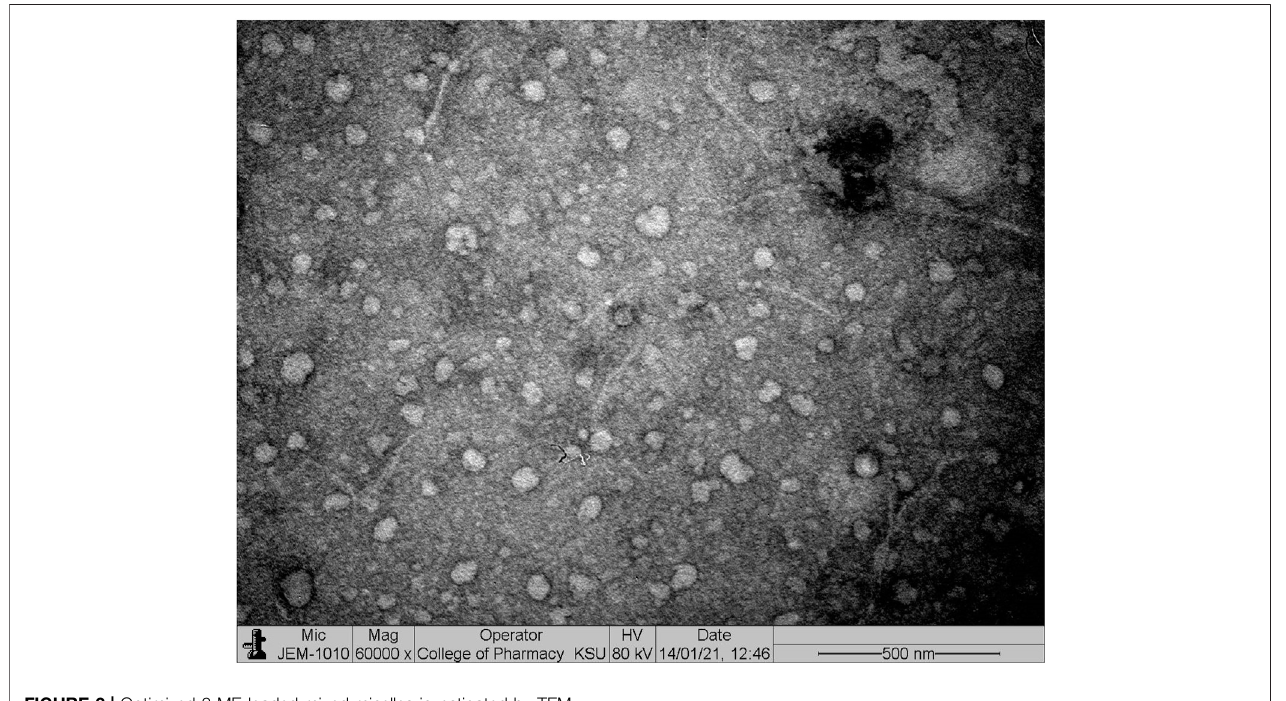
FIGURE 2 | Optimized 2 ME-loaded mixed micelles investigated by TEM.